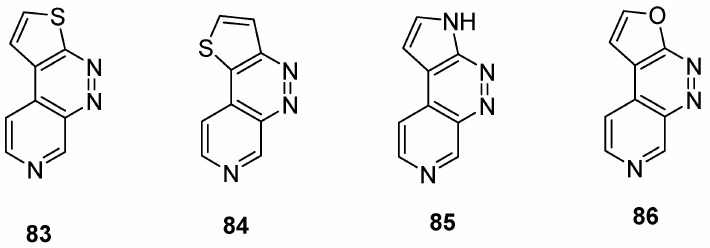
Figure 3. Pyridopyridazines fused with five-membered